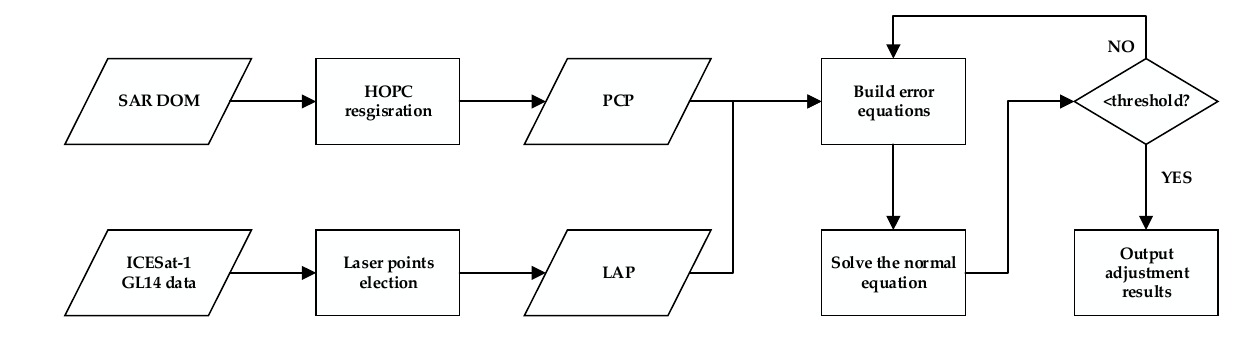
Figure 1. Flow chart of method.